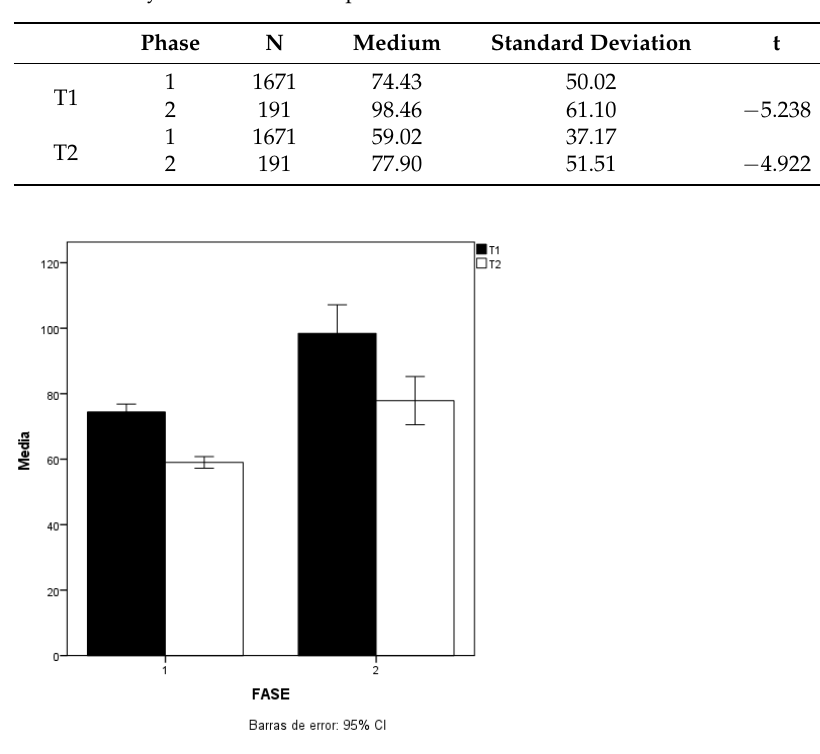
Figure 1. Comparisons of T1 and T2 in phase 1 and 2.